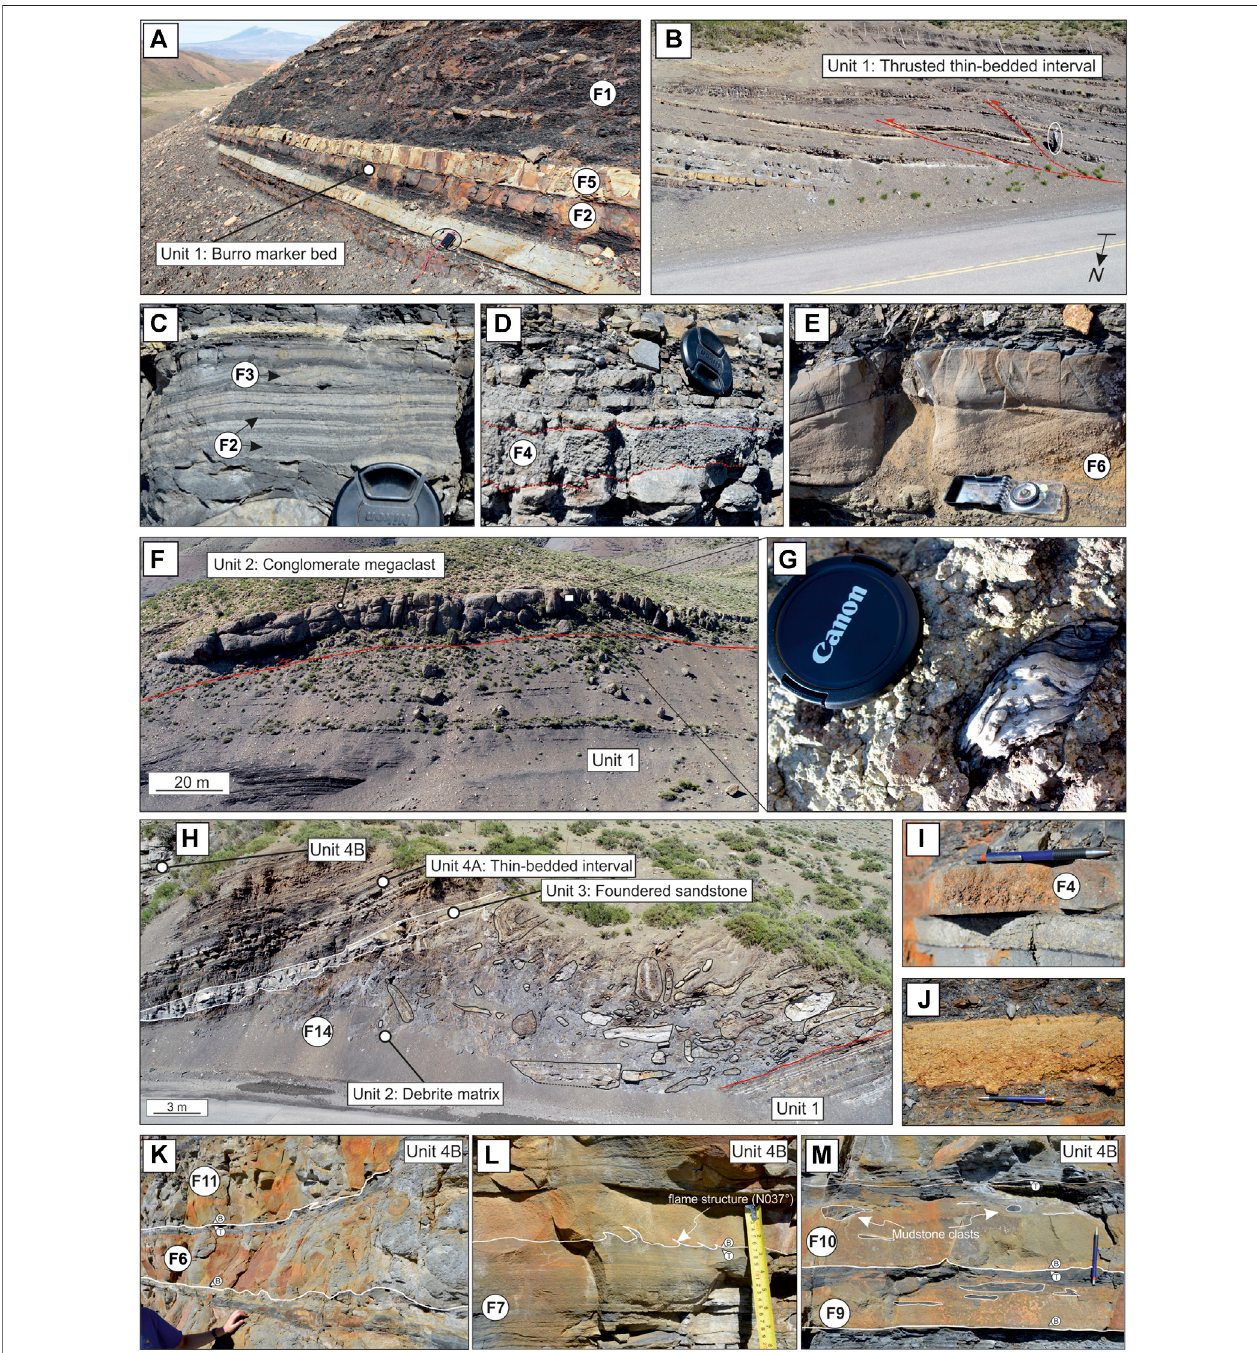
FIGURE 4 | Representative sedimentary facies photos. (A) Unit 1: Planar-laminated mudstone (F1) with a few thin-to medium-bedded intercalated siltstone beds (F2) (Burro marker bed; Datum A) and sandstone beds (F5). (B) Unit 1: Basal shear-zone characterised by imbricated thrusts with drag folding. (C) Unit 4A: Heterolithic deposits consisting in the alternation between siltstones (F2) to (very) fi ne-grained sandstones (F3). (D) Unit 4A: Gravelly thin bed (F4) locally eroded into fi ne-grained sandstones(F3). (E) Unit4A: Medium-bedded sandstones with cross-bedding(F6). (F) Unit 2: 140 mlong conglomerate megaclast, bearing oysterand belemnite fragments,and sitting above Unit1.Oysterfragment highlighted intheinsetbox (G) . (H) Unit 2,3and4A: Foundered sandstonesonlappingthematrix-rich debrite (F14) withdeformedheterolithicmegaclastsdrapedbythethin-beddeddepositsofUnit4A. (I) Unit4A:Gravellyand (J) Tuff-markerbedwithin4A.Seethecorrelation Panels 3B , 8 (red and white dashed lines). (K) Unit 4B: Amalgamated medium-(F6) to thick-bedded (F11) sandstones. (L) Unit 4B: Medium-bedded banded sandstone (F7) overlain by massive matrix-poor sandstones (F5). Note the vergent fl ame structures within the amalgamation surface (M) Unit 4B: Thin- (F9) and medium-bedded (F10) hybrid event beds type 2 (cf. Haughton et al., 2009) with a linked debrite consisting of matrix-rich sandy division with elongated mudstone clasts.